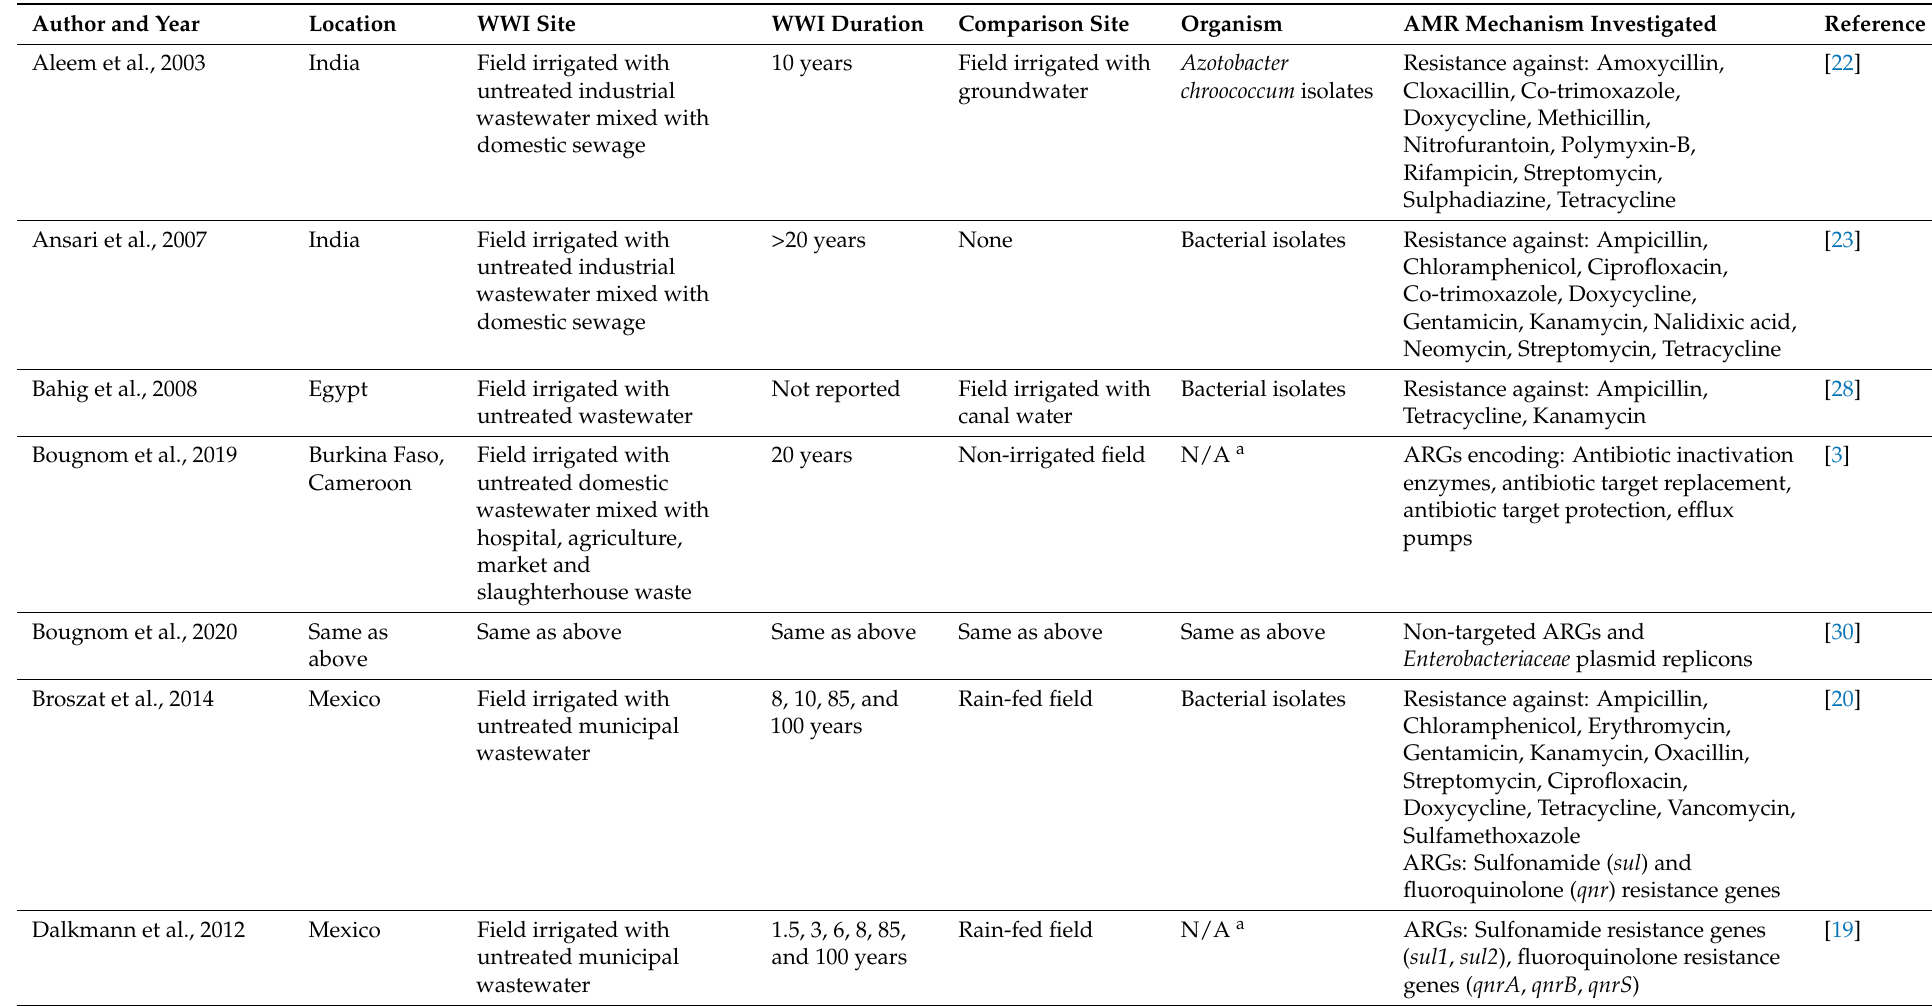
Table 1. Characteristics of studies on irrigation with untreated